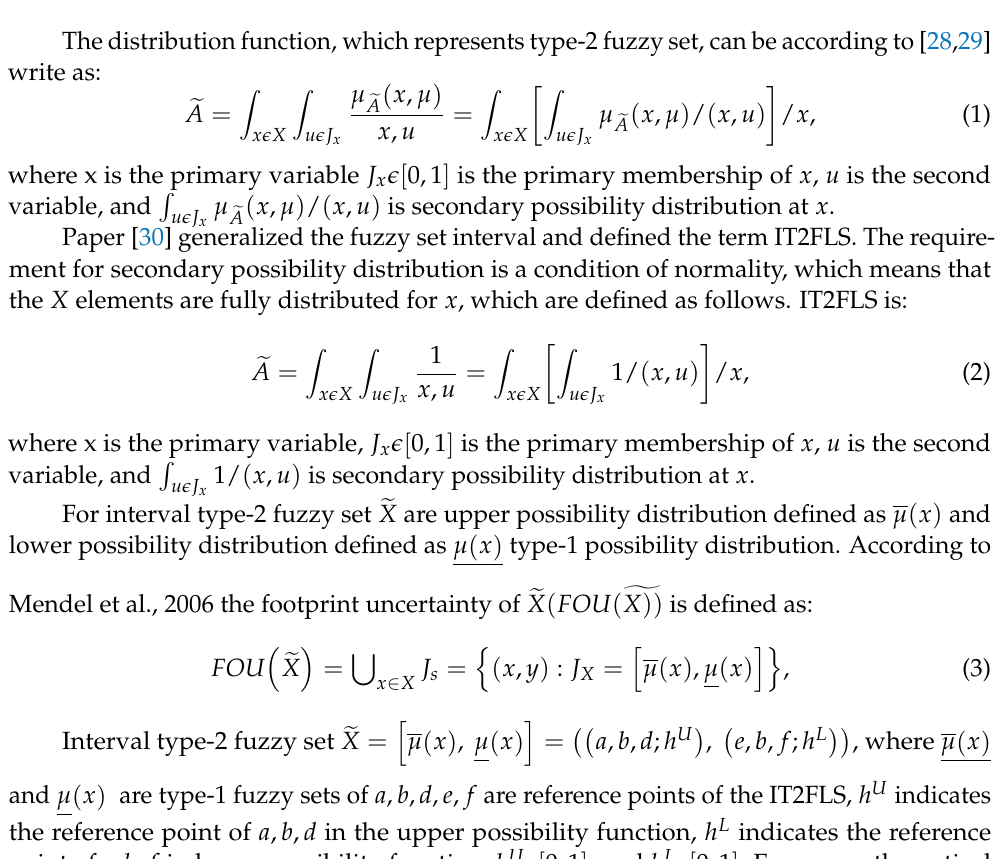
Figure 1. The difference between ( a ) T1FS and ( b )